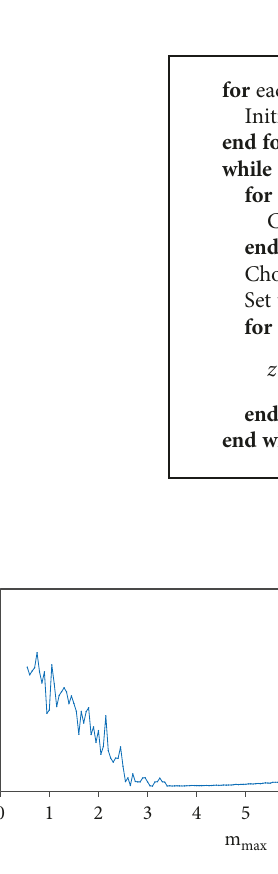
Figure 5: Performance variation according to m with 4 leading particles are applied to fi nd the minimum of the Rosenbrock